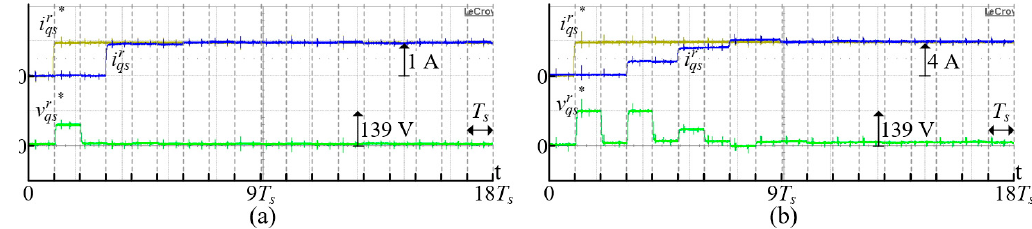
Figure 18. q -axis current and voltage when the motor is at standstill and the current command steps from ( a ) 0 A to 1 A, ( b ) 0 A to 4 A.